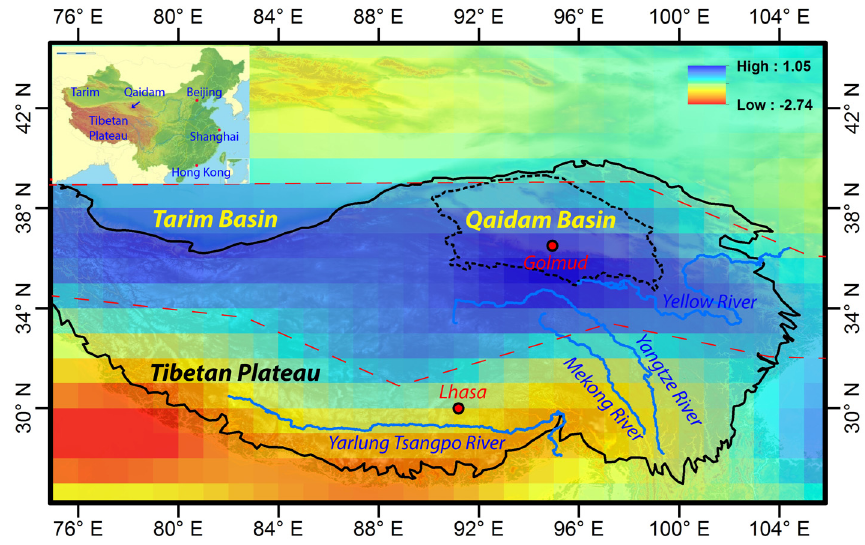
Fig 1. Spatial distribution of changing rates of TWS (mm/month) in the TP from 2003 to 2012, indicating an increase in water storage in the NTP, especially in the QB. The background shows the topography of the area.